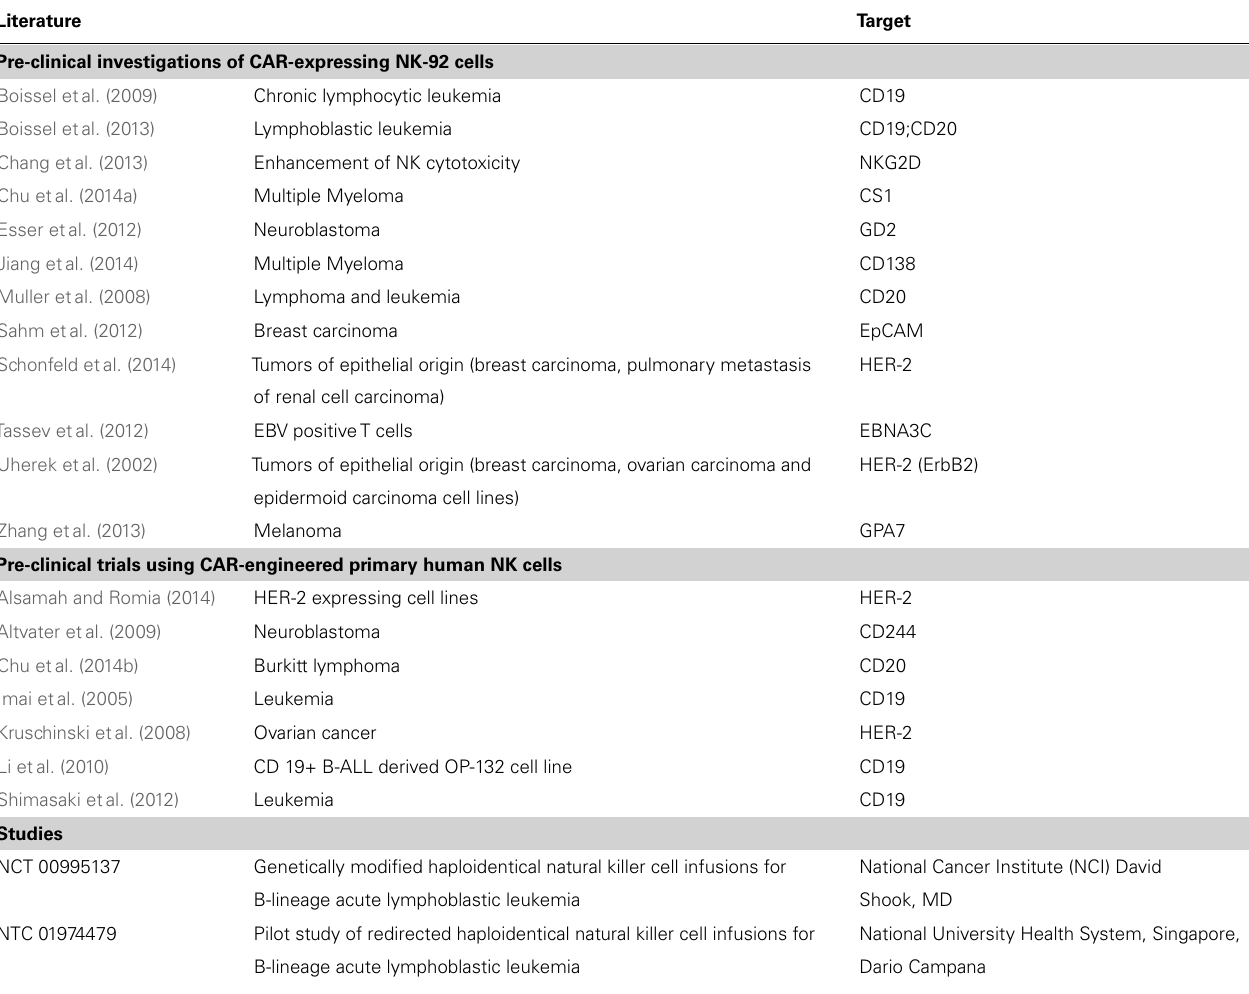
Table 1 | Pre-clinical trials using CAR-engineered primary human NK cells and Pre-clinical investigations of CAR-expressing NK-92 cells.